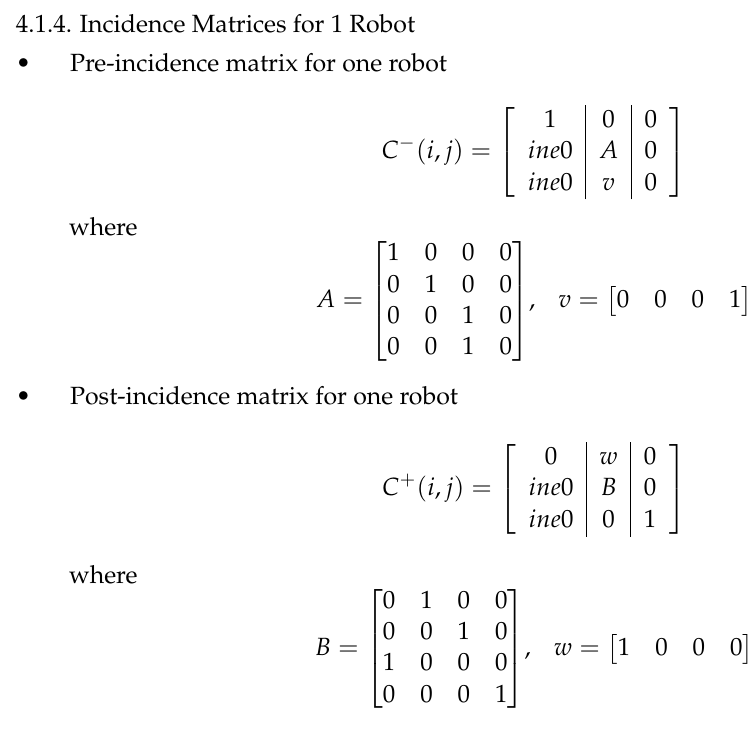
Figure 11. Modeling PN layer −